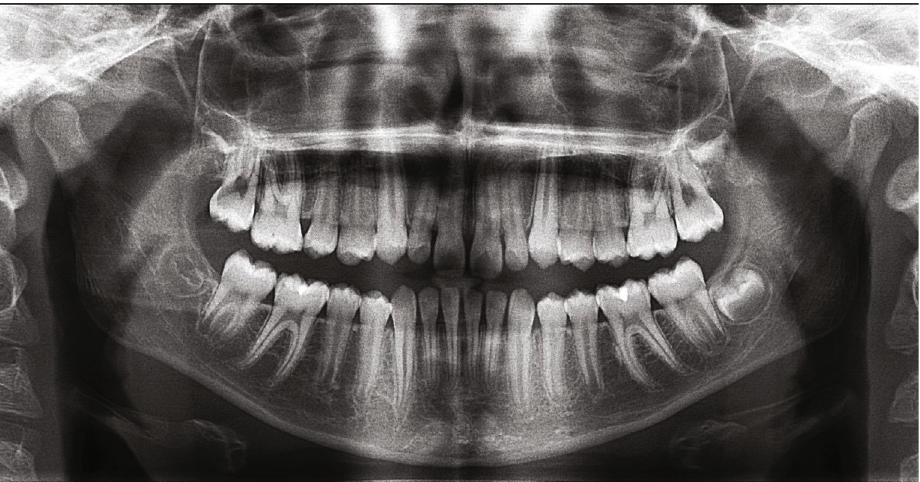
Figure 3: Panoramic radiograph before